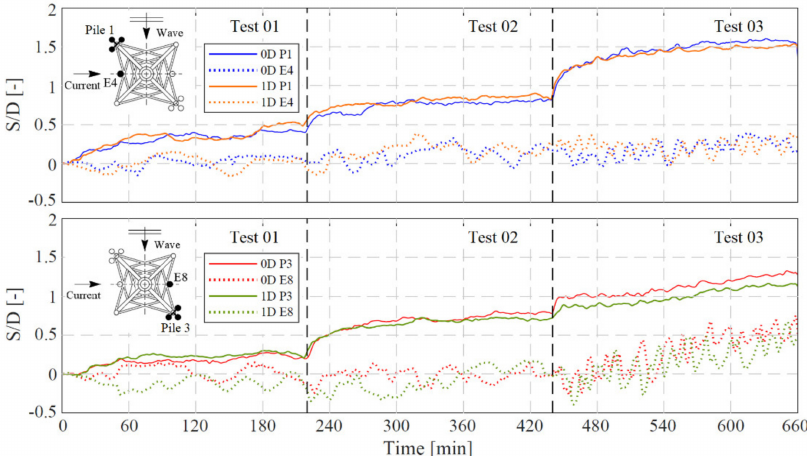
Figure 3. Scour development of Tests 1–3 with a current velocity of U c = 10.1, 22.5 and 38.8 cm / s with 0D (present study) and 1D (Welzel et al. [24]) distance tests compared with each